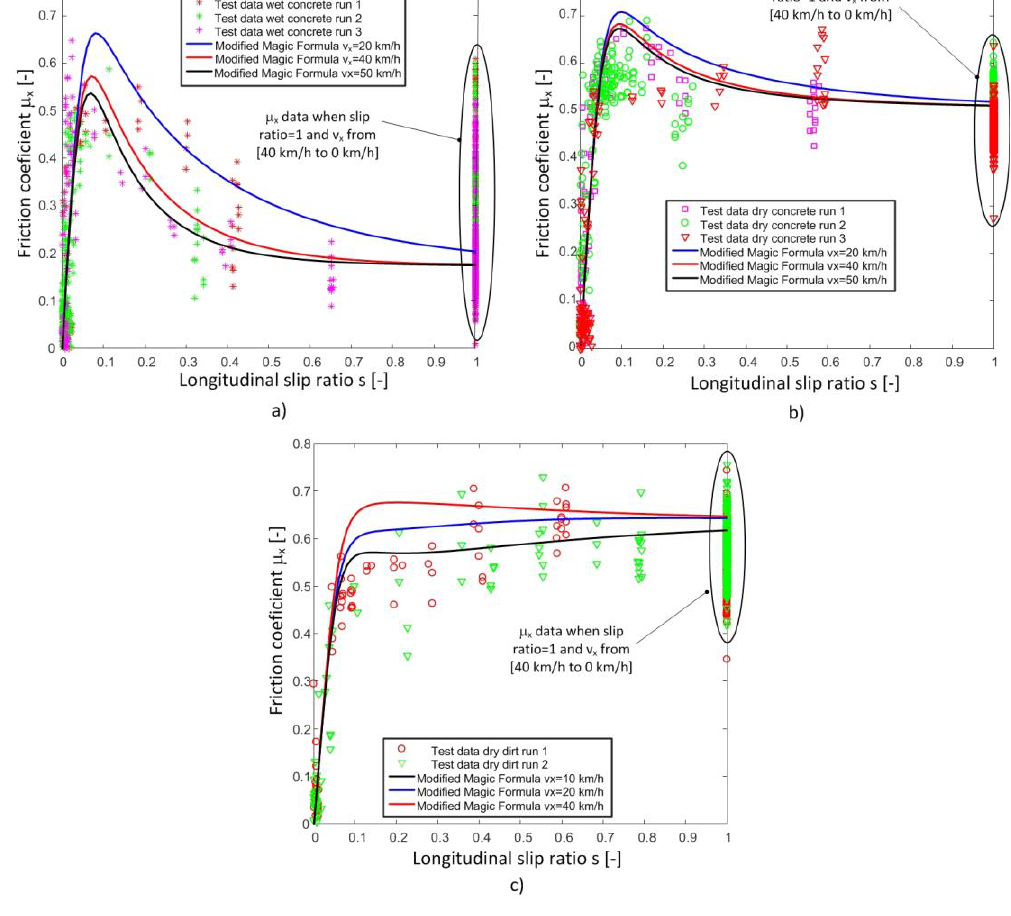
Table 5. Measures with British Pendulum and SCRIM on A-30 and MU-30.